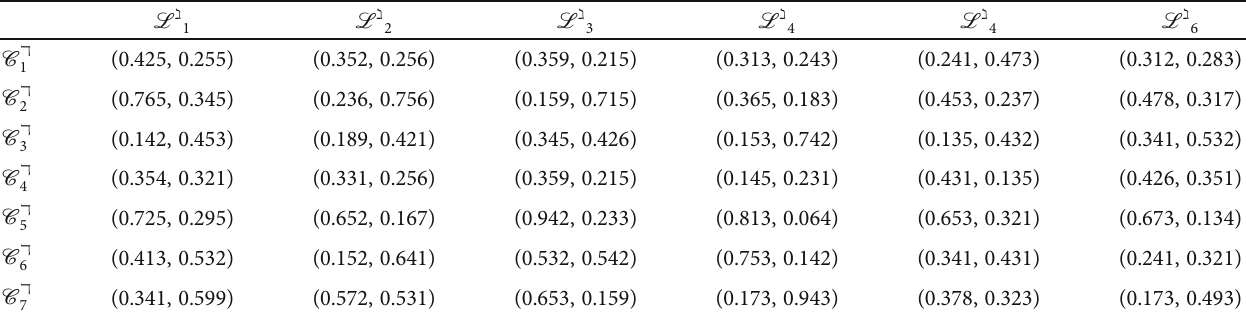
Table 4: Assessment matrix acquired from DMs.